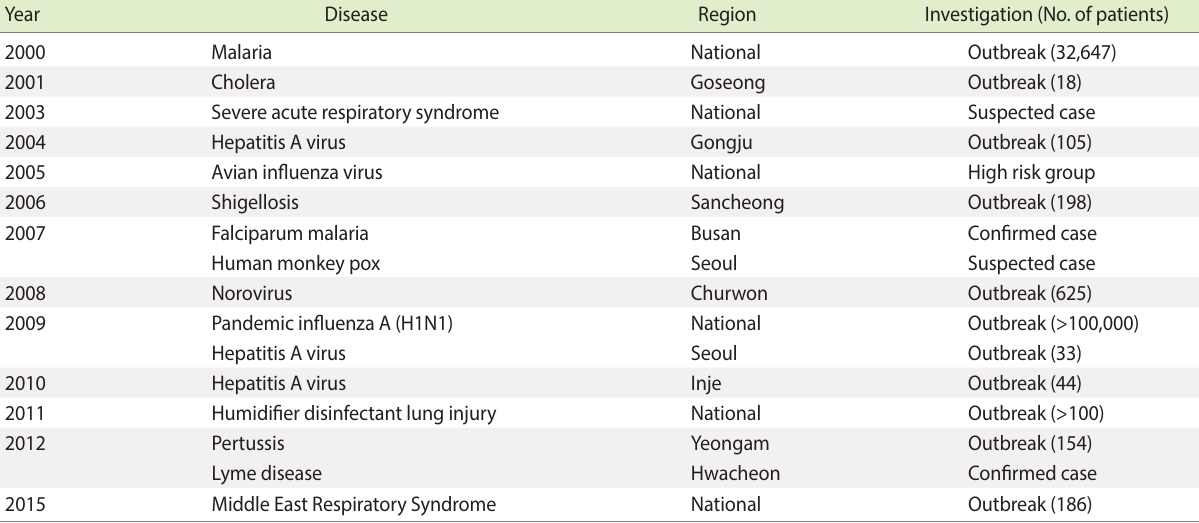
Table 5. Major outcomes of field epidemiologists by the